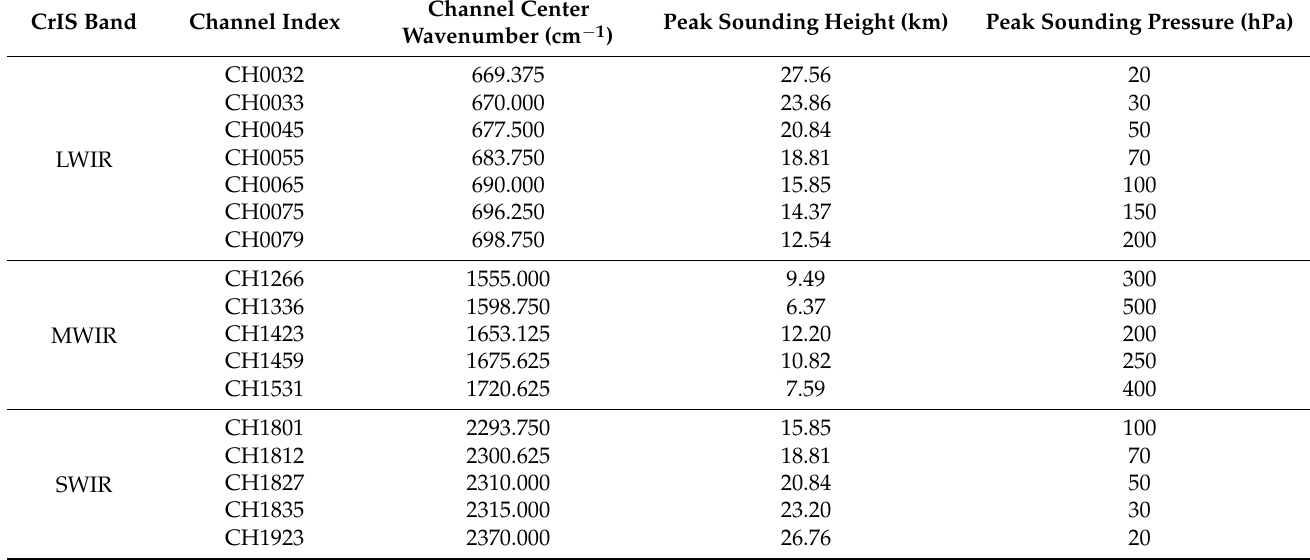
Table 1. Time series from selected CrIS channels covering temperature and water vapor sounding channels at represented pressures and altitude heights for comparison